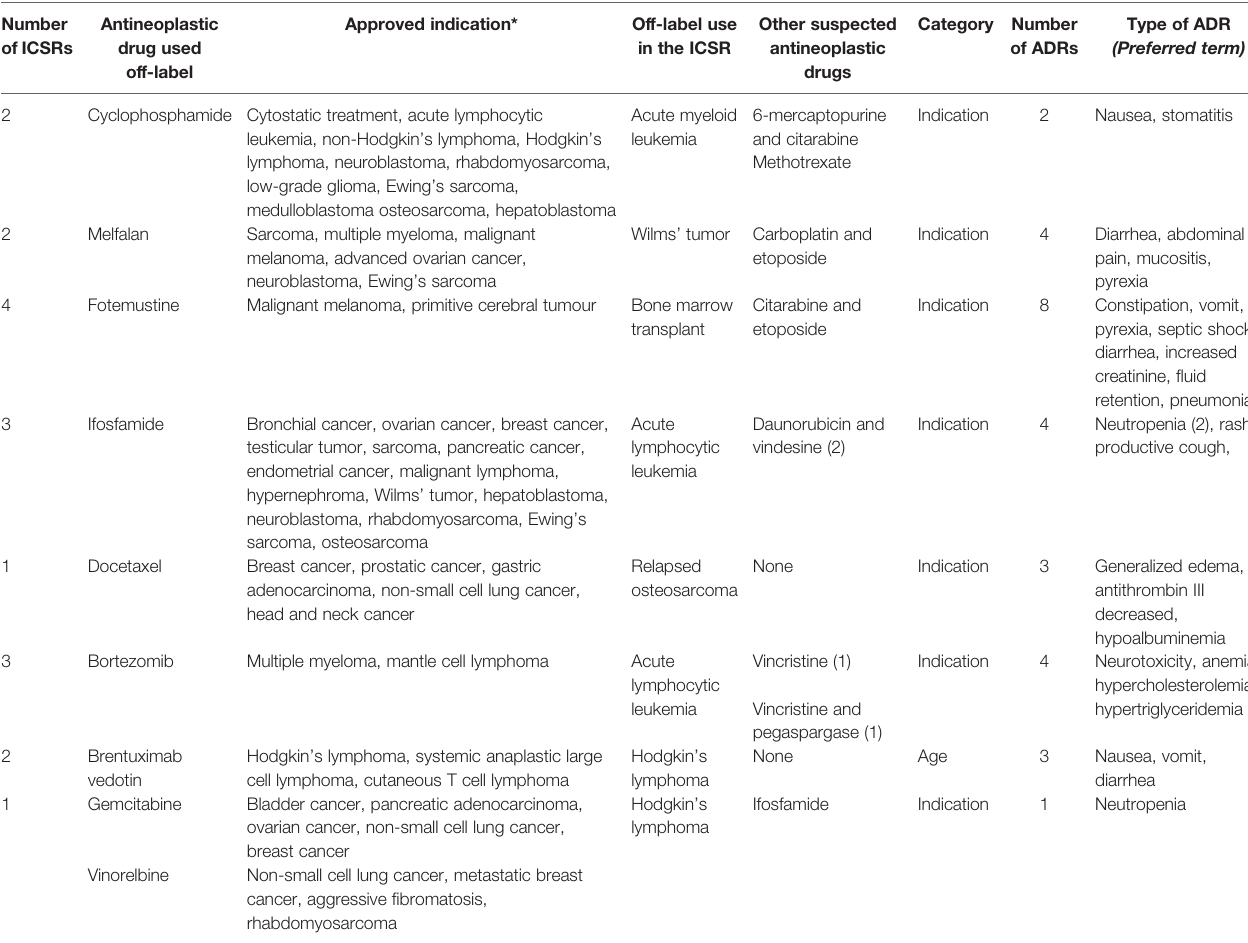
*Based on the Summary of Product Characteristics (SmPC) and the pediatric list of medicinal products (Italian Law 648/96).